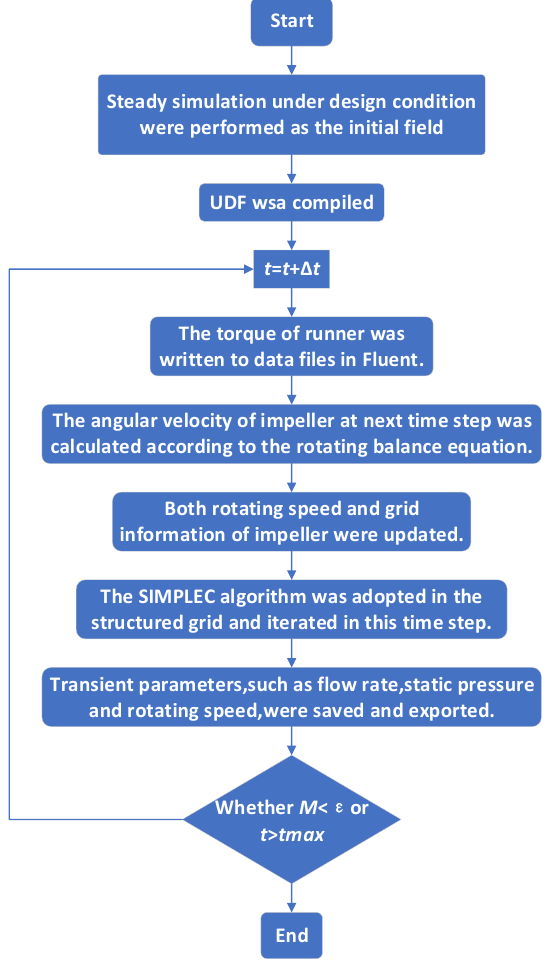
Figure 9. Algorithm routines of the runaway transient simulation [35].